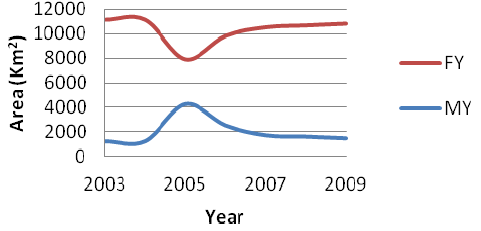
Figure 8. Multiyear (MY) and firstyear (FY) sea ice extent for the mid October period in each year for McMurdo Sound. Extensive HL measurements were carried out in November 2009. By means of differential GPS measurements to remove helicopter altitude variations and ground validated air to surface laser measurements freeboard was obtained. Two field sites tracks 15 and 9, respectively. The field measurements